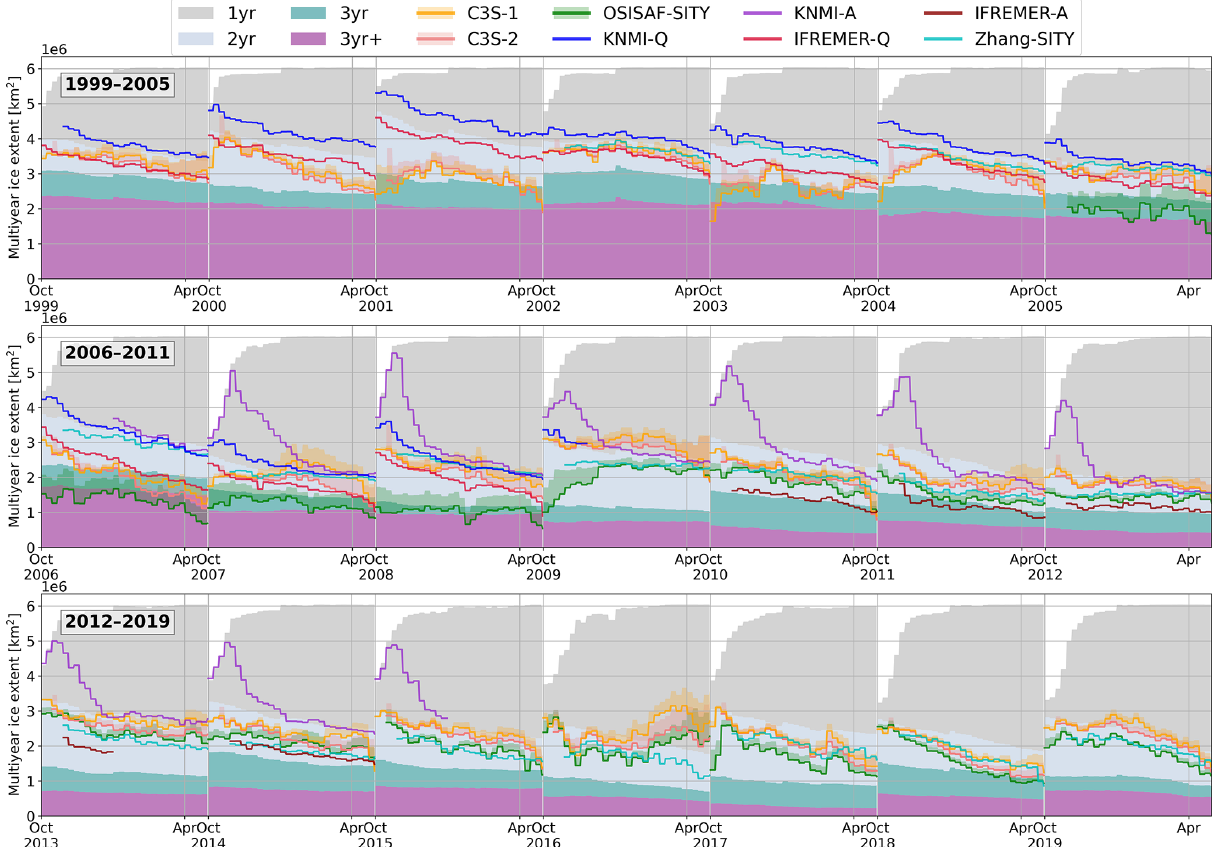
Figure 4. Arctic MYI extent variation in SITY products and NSIDC-SIA. The solid line represents weekly MYI extent of the SITY product, the dashed line represents daily MYI extent, and the shaded area in the same colour as the respective solid line represents the ambiguous extent from Amb class (in C3S-1, C3S-2 and OSISAF-SITY), while the stacked block in the background represents ice extent with the corresponding age of NSIDC-SIA. Table 3. Bias and mean absolute deviation (MAD) between the SITY products and NSIDC-SIA in MYI and FYI extent. Bold font marks the smallest bias and MAD among all the SITY